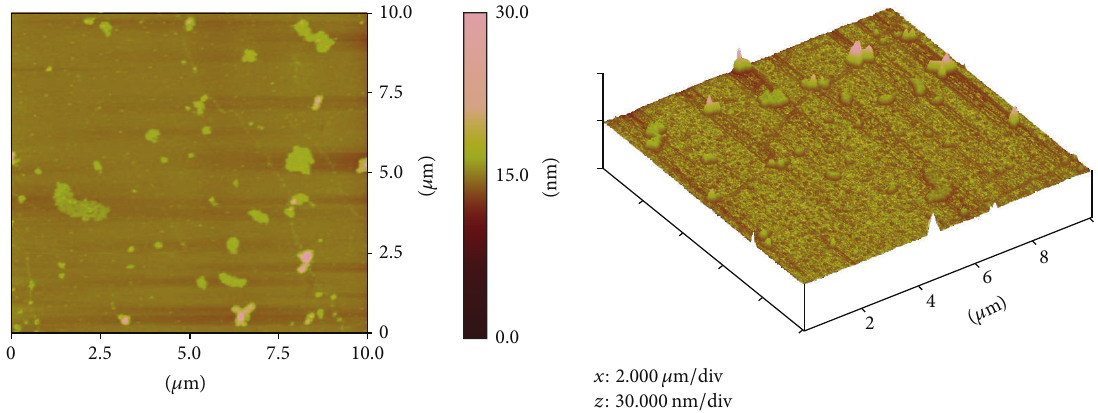
Figure 7: AFM plane height map and the three-dimensional topography (after